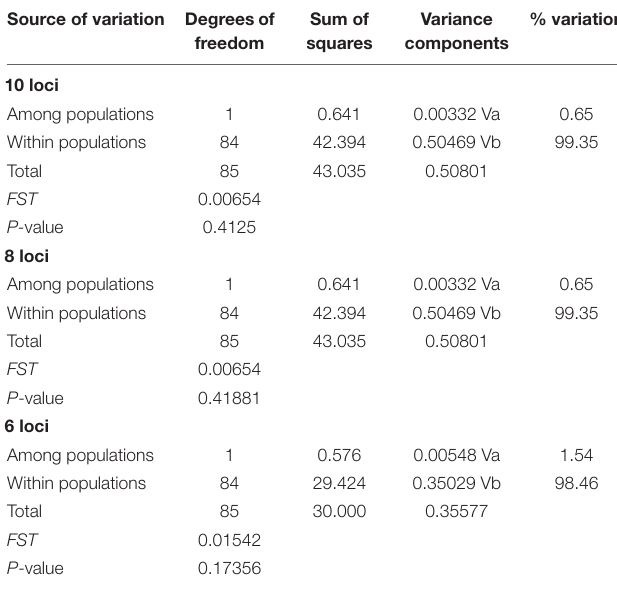
TABLE 5 | AMOVA statistics of franciscana for three different combination of microsatellite